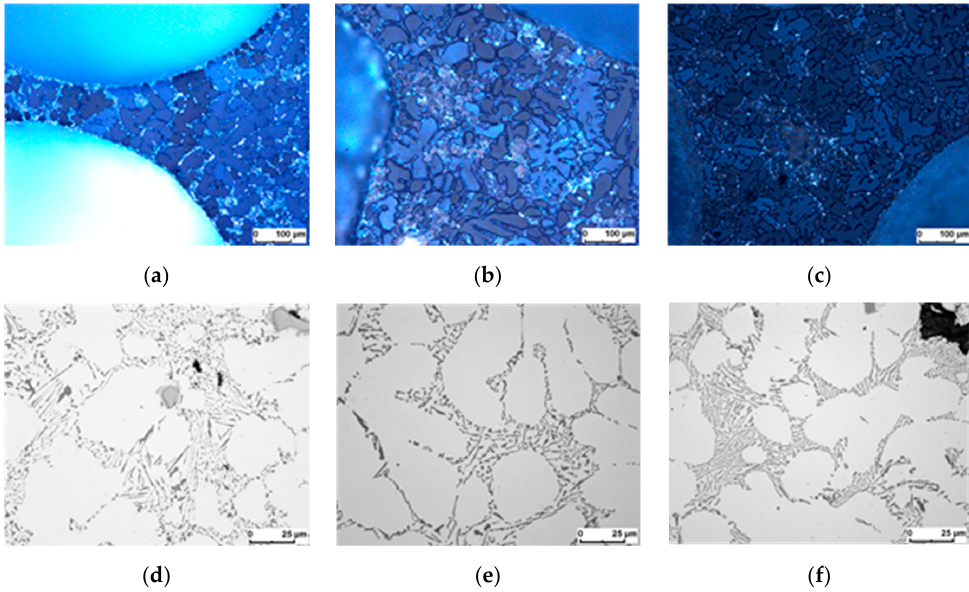
Figure 11. Foam microstructure, ( a – c ) Barker etching emphasizing grain sizes, ( d – f ) expression of the eutectic phase. ( a , d ) Reference material AlSi7 with conventional, as received foaming agent, ( b , e ) with 465 ppm Sr and ( c , f ) with 465 ppm Ti as TiB 2